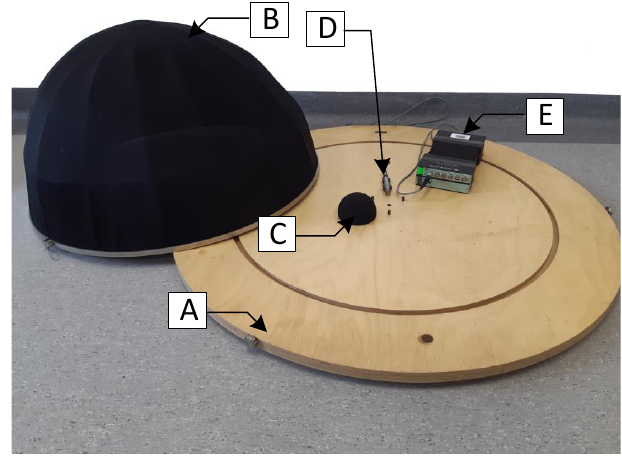
Figure 1. Elements of measuring station: A—reflective board, B—outer wind protection, C—inner wind protection, D—microphone, E—PULSE LAN-XI type 3050-A module.